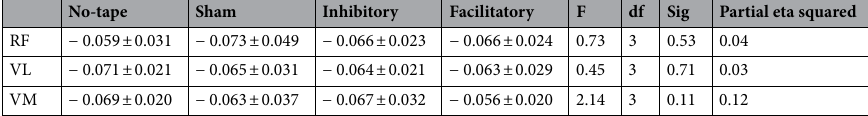
Table 3. MDF slopes of the RF, VM, and VL in four conditions (no-tape, sham, inhibitory and facilitatory KT) and one way repeated measures ANOVA results. VM Vastus Medialis, RF Rectus Femoris, VL Vastus